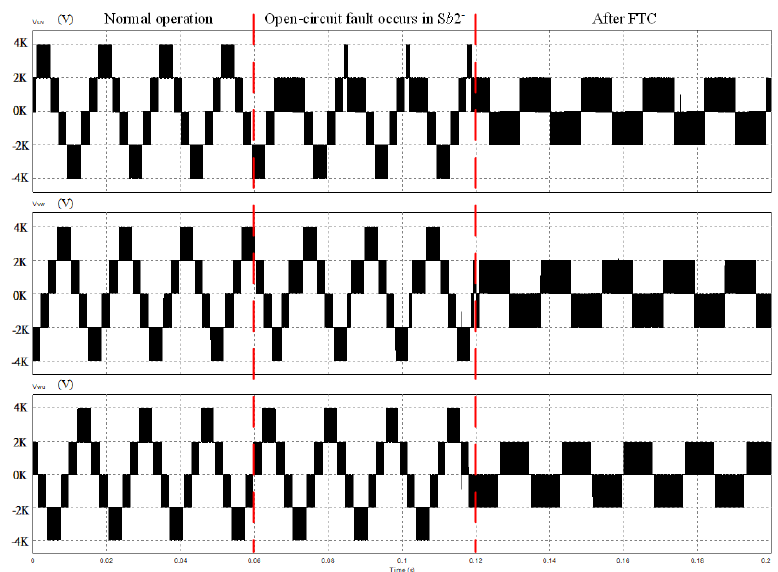
Figure 20. Output voltage with an open-circuit fault in S b 2 − after FTC.